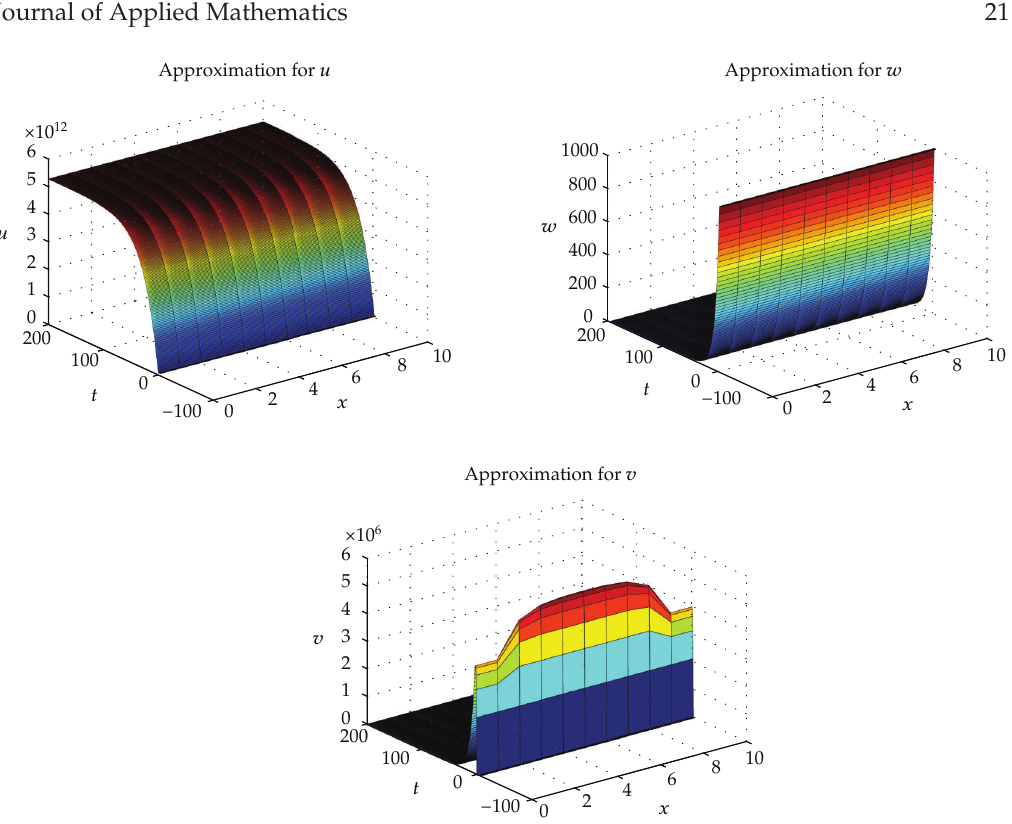
Figure 1: Simulations with parameters L (cid:8) 2 11 , d (cid:8) 3 . 78 − 2 , a (cid:8) 3 . 38 d , p (cid:8) 0 . 67, β (cid:8) 1 . 45 − 6 , k (cid:8) 5 . 18 3 , m (cid:8) 0 . 2, and D (cid:8) 0 . 5. R 0 (cid:8) 0 .